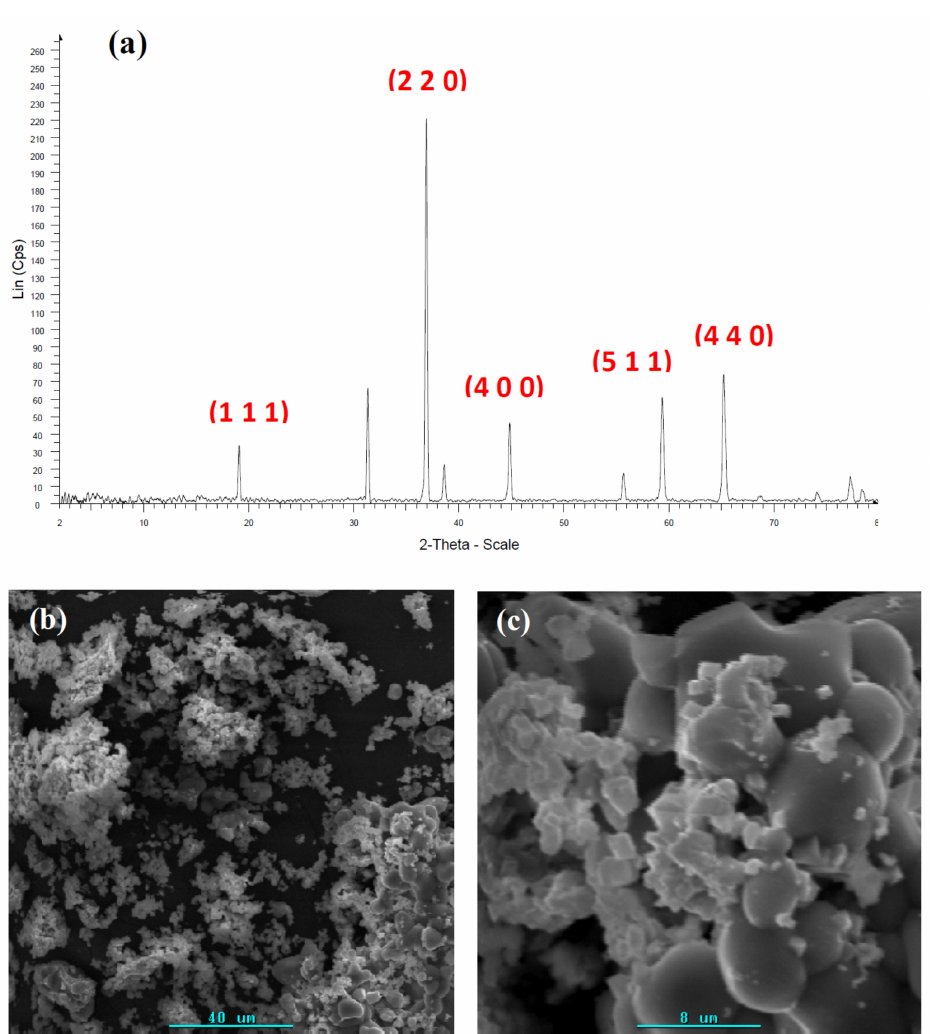
Figure 7. XRD pattern ( a ) and SEM images ( b , c ) for the pyrolytic product from Chitosan · (CoCl 2 ) n .